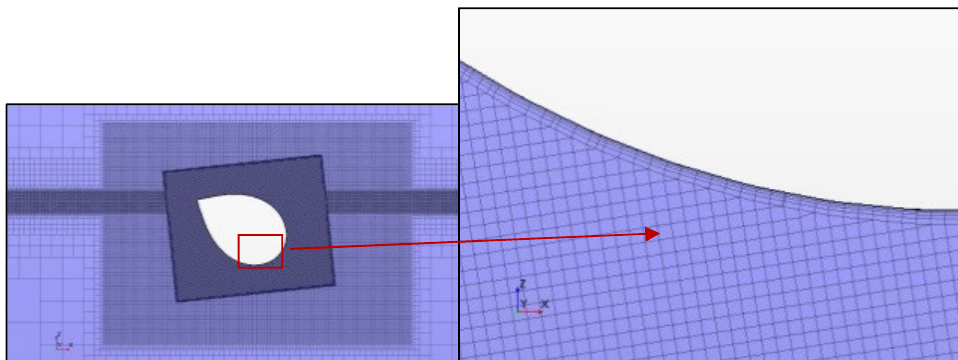
Figure 5. Initial mesh generation over the computational domain.